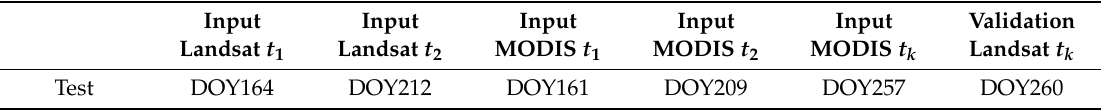
Table 1. Input images of the enhanced spatial and temporal adaptive reflectance fusion (ESTARFM) model for prediction and